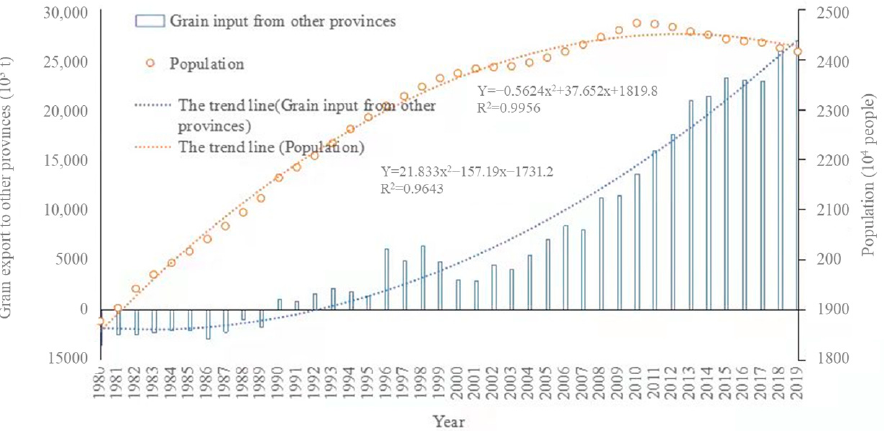
Figure 1. Grain export to other provinces from Inner Mongolia Autonomous Region from 1980 to 2019. Source: National Bureau of Statistics (http://www.stats.gov.cn/tjsj/) (accessed on 26 January 2022). Note: Grain demand per capita of China is 400 kg with a balanced diet achieved [26].